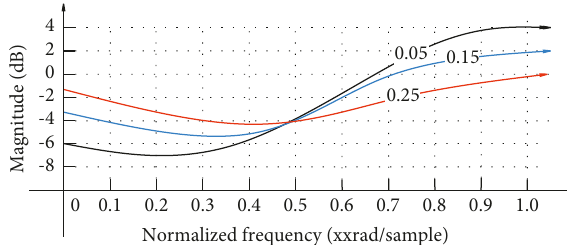
pe of 0.25, 0.15,